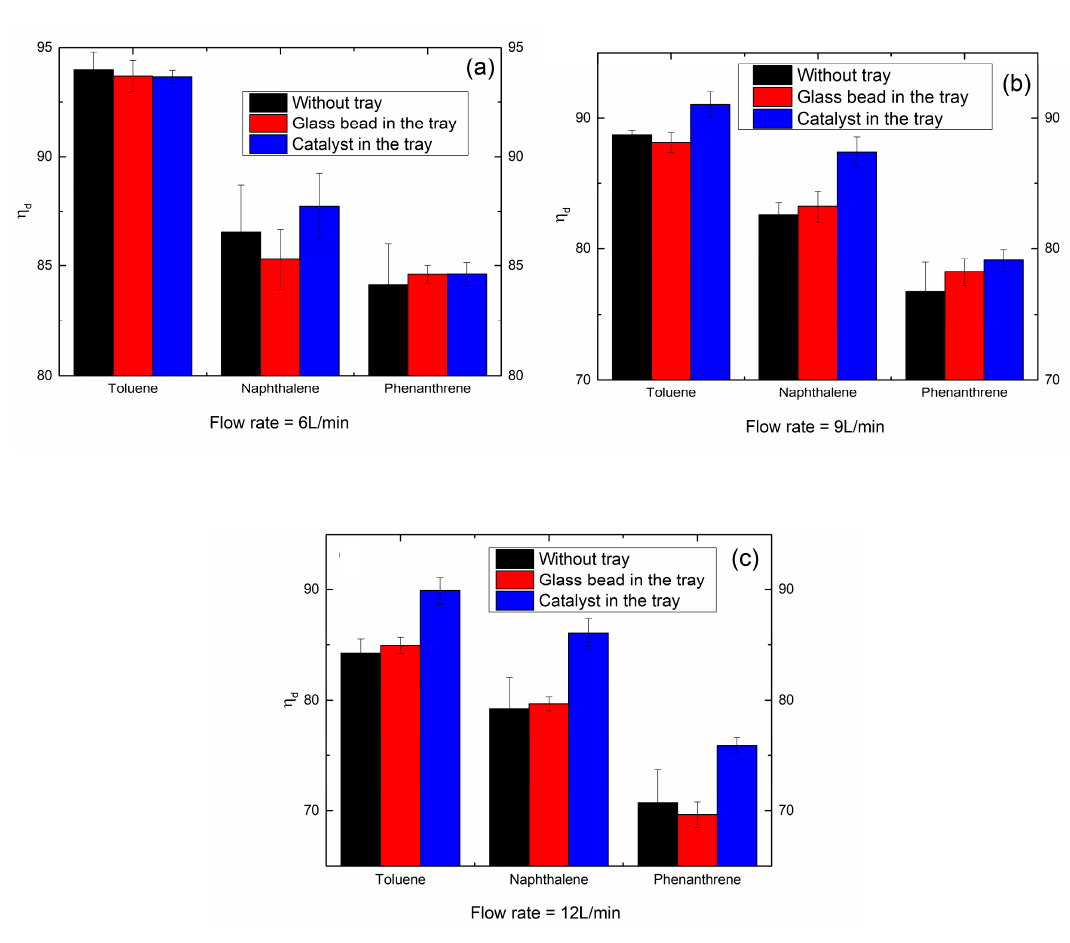
Figure 18. Effect of catalyst on destruction efficiency at flow rates of ( a ) 6 NL/min, ( b ) 9 NL/min and ( c ) 12 NL/min.